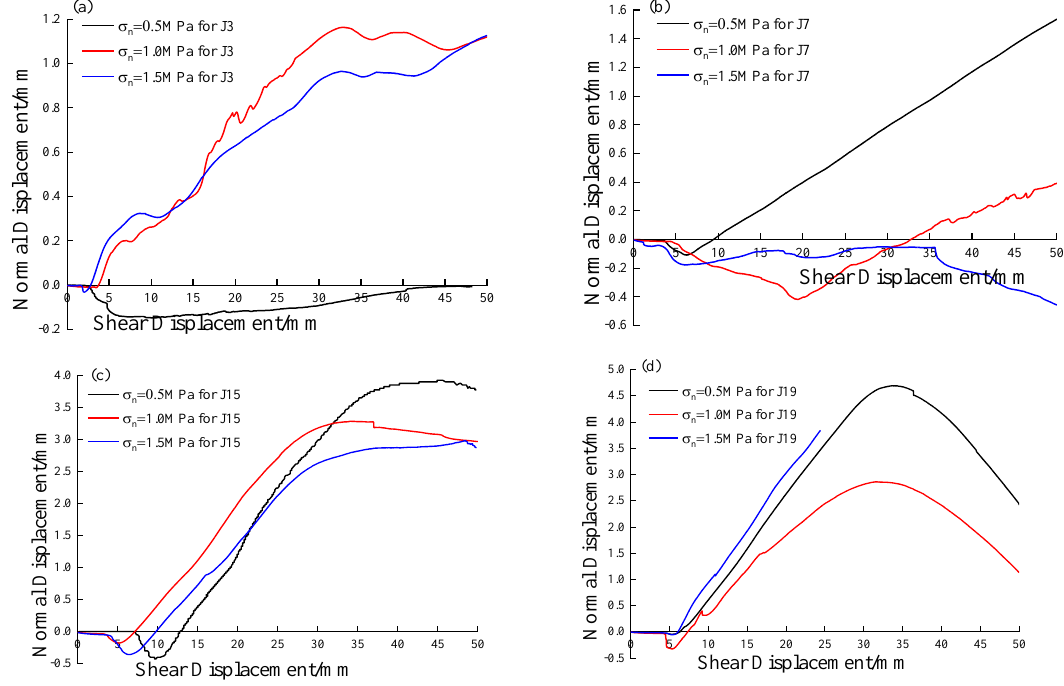
Fig.7. Normal displacement versus shear displacement curves for without filling joint. Figure 7: Normal displacement versus shear displacement curves for without filling joint